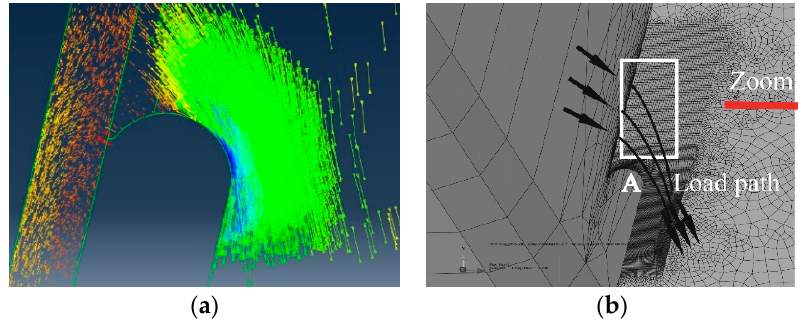
Figure 9. Stress flow analysis around a cutout at the U-rib to diaphragm connection: ( a ) vectors of principal stresses and ( b ) stress flow and load path.